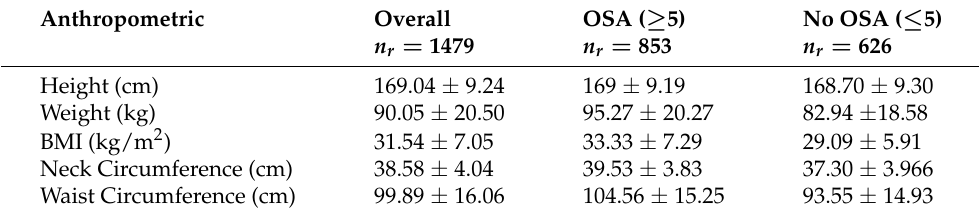
Table A2. Anthropometric characteristics of cohort expressed as mean ± standard